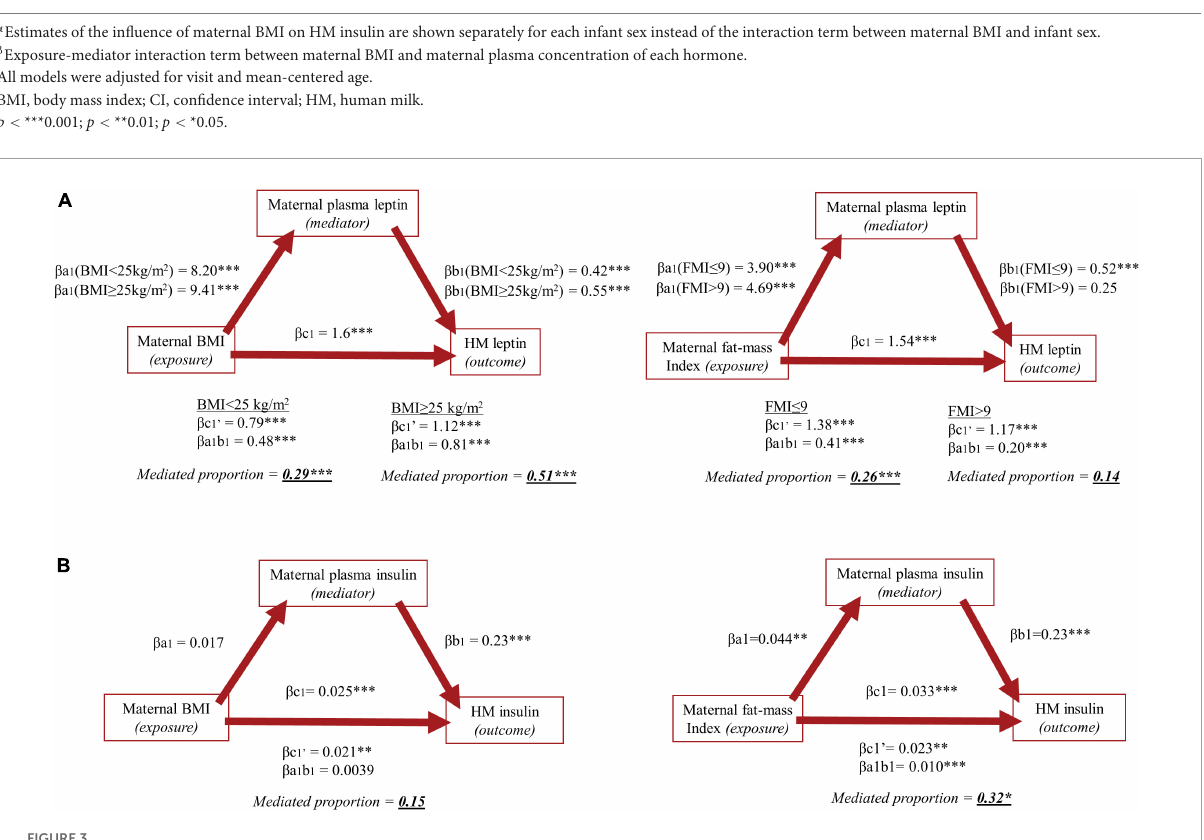
to number of complete cases in the mediation analyses (data not